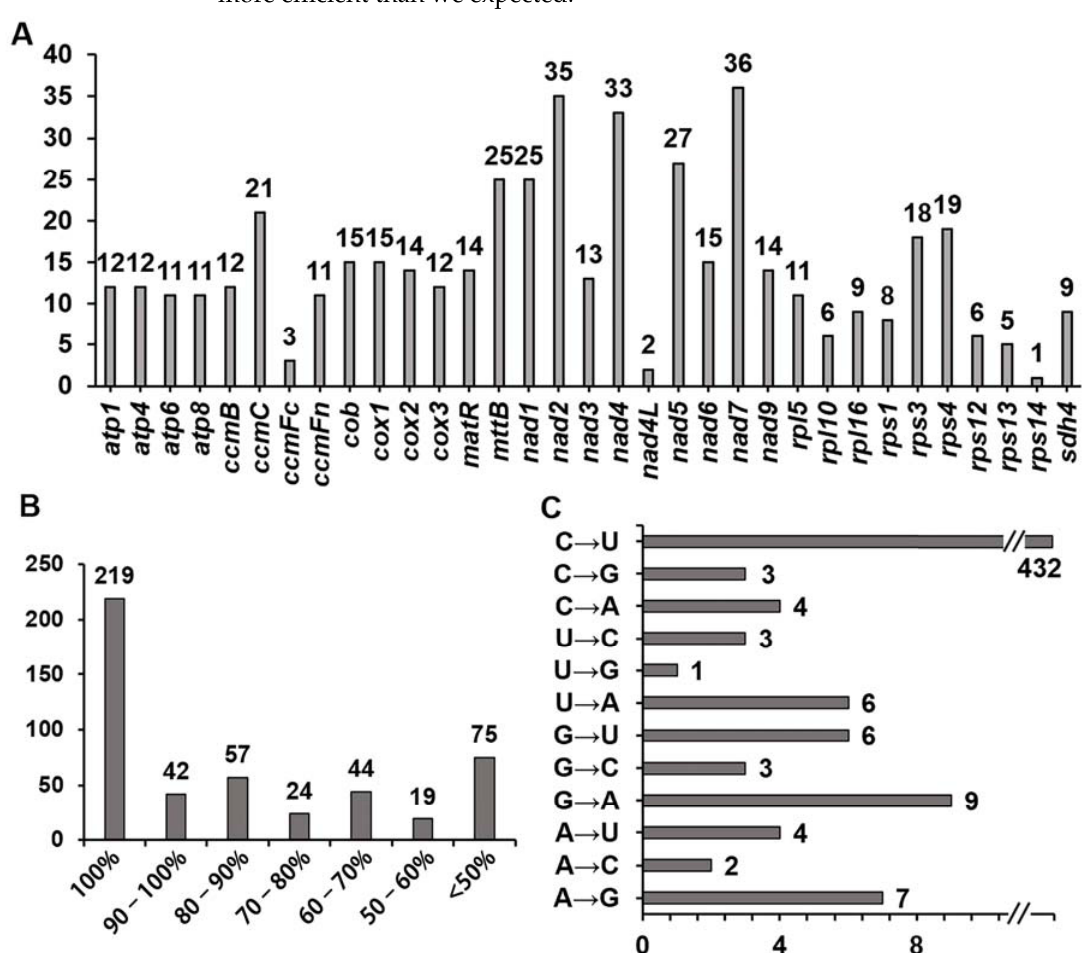
Figure 5. Characteristics of the RNA editing sites identified in PCGs of P. salicina mitogenome. ( A ) The number of RNA editing sites identified in each PCGs. ( B ) RNA editing efficiency. ( C ) RNA editing type and their number identified in all PCGs.